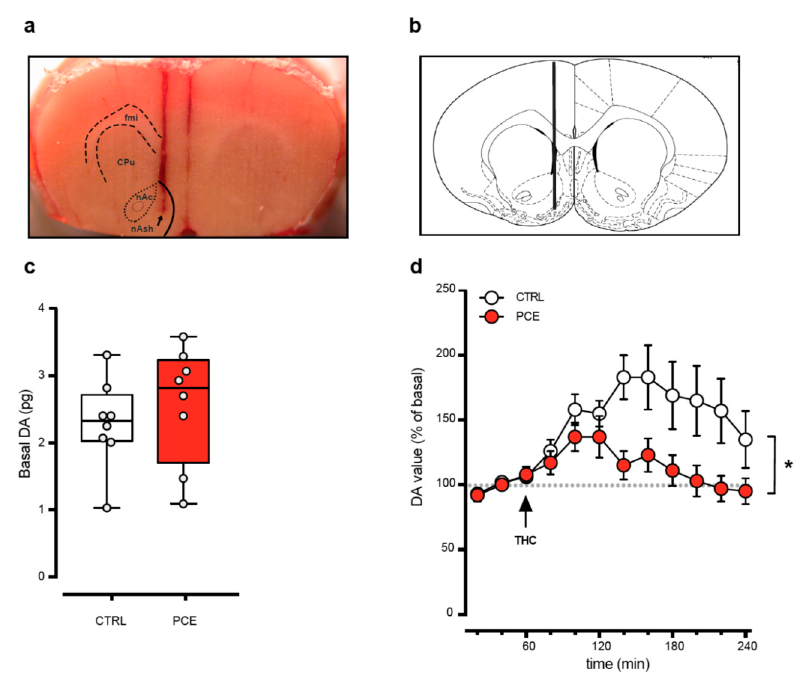
Figure 3. PCE impact on THC-induced increase of accumbal DA level in female preadolescent offspring. ( a ) Representative photograph of microdialysis probe location into the nucleus accumbens shell. The arrow indicates the tip of the probe. Abbreviations: fmi, forceps minor corpus callosum; CPu, caudate putamen; nAc, nucleus accumbens core; nAsh, nucleus accumbens shell. ( b ) Schematic representation of cerebral area targeted by the probe as indicated by the vertical line (nAsh, AP: +1.5, L: ± 0.7, V: − 7.0 from bregma) ( c ) Basal dopamine (DA) values (pg) measured in the nAsh ( n = 7–8/group). Data are expressed as pg/sample (the box-and-whisker plot shows min to max with single values). ( d ) Time course of the effect of acute THC (2.5 mg/kg i.p.) on extracellular DA levels in nAsh ( n = 7–8/group). Data are shown as percentage of baseline and are represented as mean ± s.e.m. *, p < 0.05.